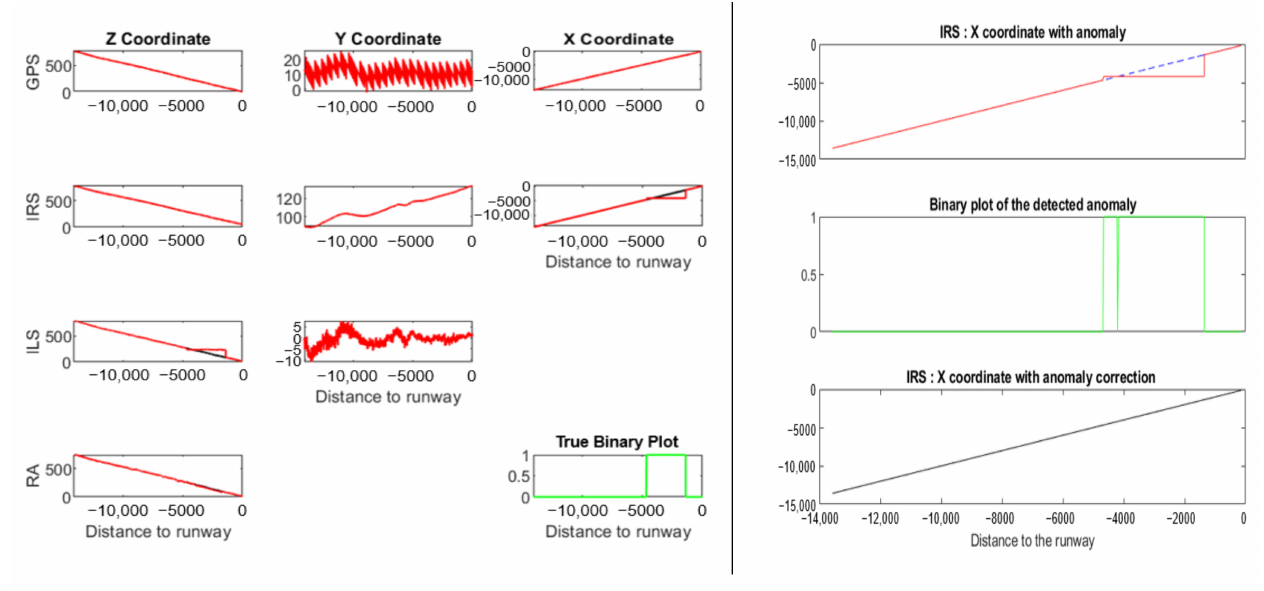
Figure 30. On the left side, coupling problem between X IRS and Y ILS for a drift anomaly on X IRS . On the right side, the anomaly detection and correction on X IRS .